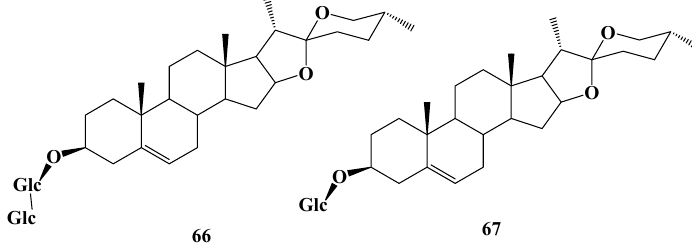
Figure 13. The chemical structures of compound 66,67 . Molecules 2019 , 24 , x FOR PEER REVIEW